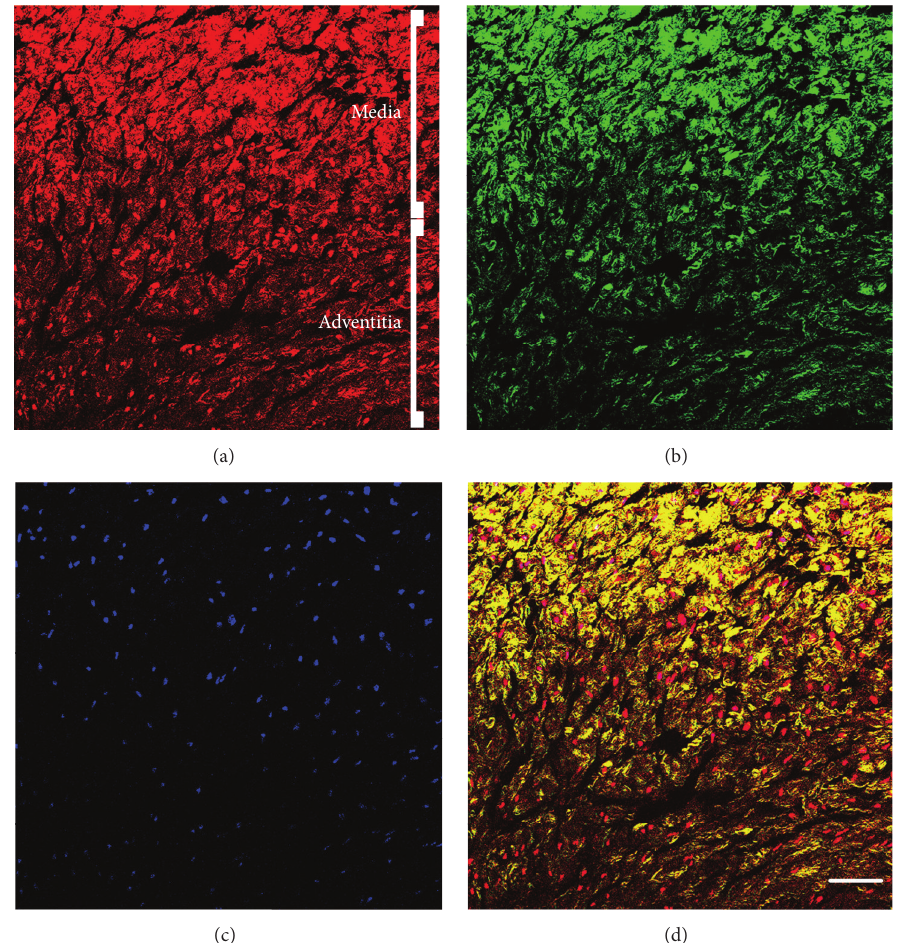
Figure 3: TPM and SHG imaging of DAPI stained umbilical cord vein showing a differential staining intensity for DAPI. (a) AF signal and (b) SHG derived from the vessel media and adventitia. Increased AF density originates from the media smooth muscle cells. In addition, more SHG is observed in the media due to higher collagen content, as expected. (c) An increasing gradient in DAPI fluorescence was observed towards the media of the umbilical vein. (d) Merged image. Scale bar = 50 𝜇